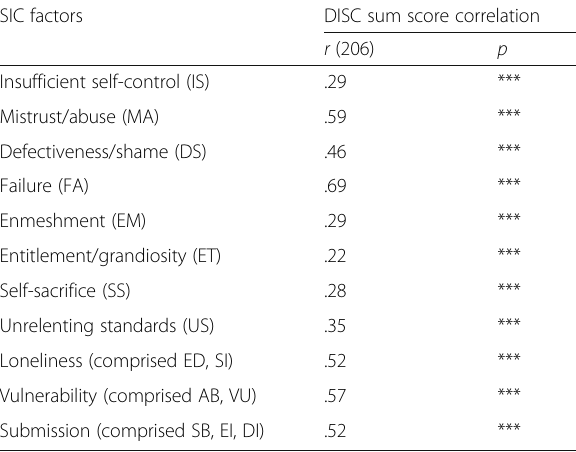
Table 5 Criterion validity: correlations between the factors proposed by the SIC and their DISC counterparts ( N = 206) SIC factors DISC sum score correlation r (206)